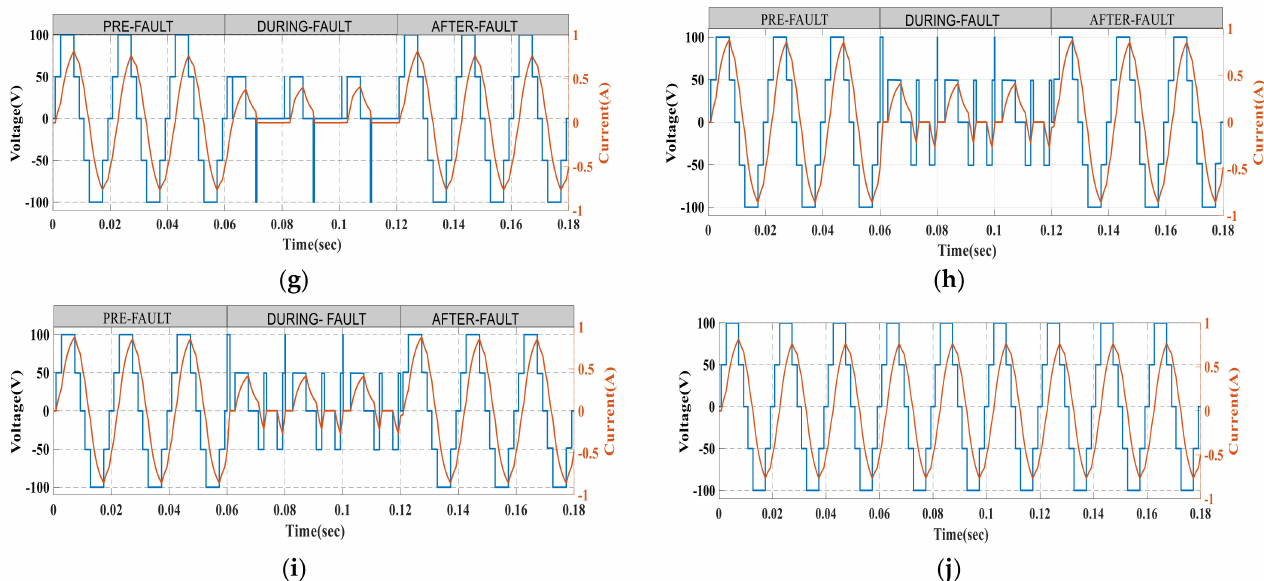
Figure 9. ( a ) Fault in Switch S 1 /S 1 S 4, ( b ) fault in switch S 2, ( c ) fault in switch S 3, ( d ) fault in switch S 4, ( e ) fault in switch S 5, ( f ) fault in switch S 6, ( g ) fault in switch S 7 /S 1 S 7, ( h ) fault in switch S 8 /S 1 S 8, ( i ) fault in switch S 9 /S 1 S 9, and ( j ) output of PUC5 result in normal condition.